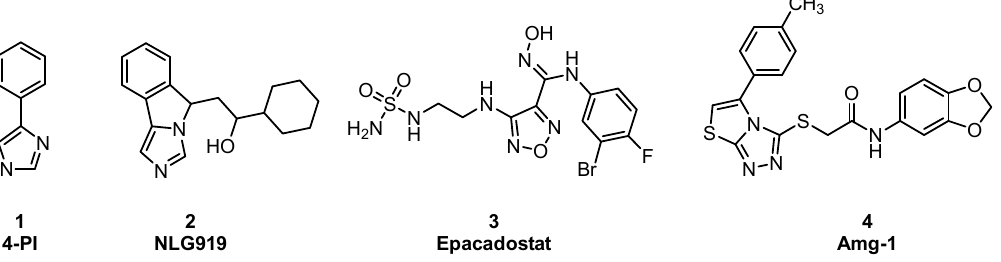
Figure 1. Chemical structures of four IDO1 inhibitors.